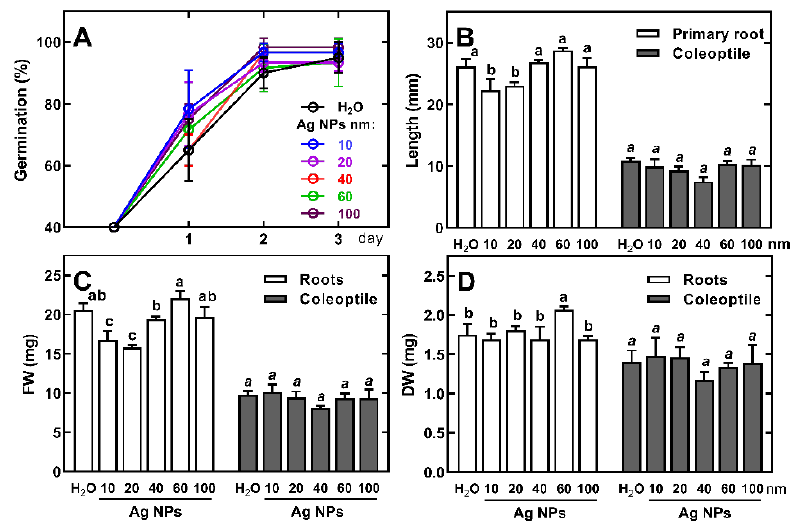
Figure 2. The effect of citrate-stabilized Ag NPs (at 20 mg/L) with various sizes (in the range of 10–100 nm) on the germination of the grain ( A ), length of primary seminal root and coleoptile ( B ), fresh weight (FW, C ), and dry weight (DW, D ) of roots and coleoptile of 3-day-old seedlings of wheat ( Triticum aestivum L. cv. ‘Ostka Strzelecka’). Values are means ( n = 3) ± SD ( A ) or + SD ( B – D ). The same letters above the bars ( C , D ) indicate no significant ( p < 0.05) differences after the ANOVA and Tukey’s post hoc corrections.